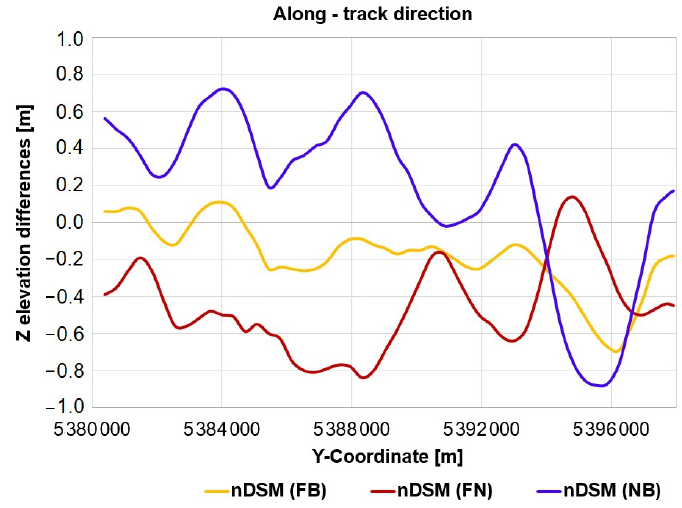
Figure 14. Elevation corrections shown as profile-height differences for pairwise Pléiades